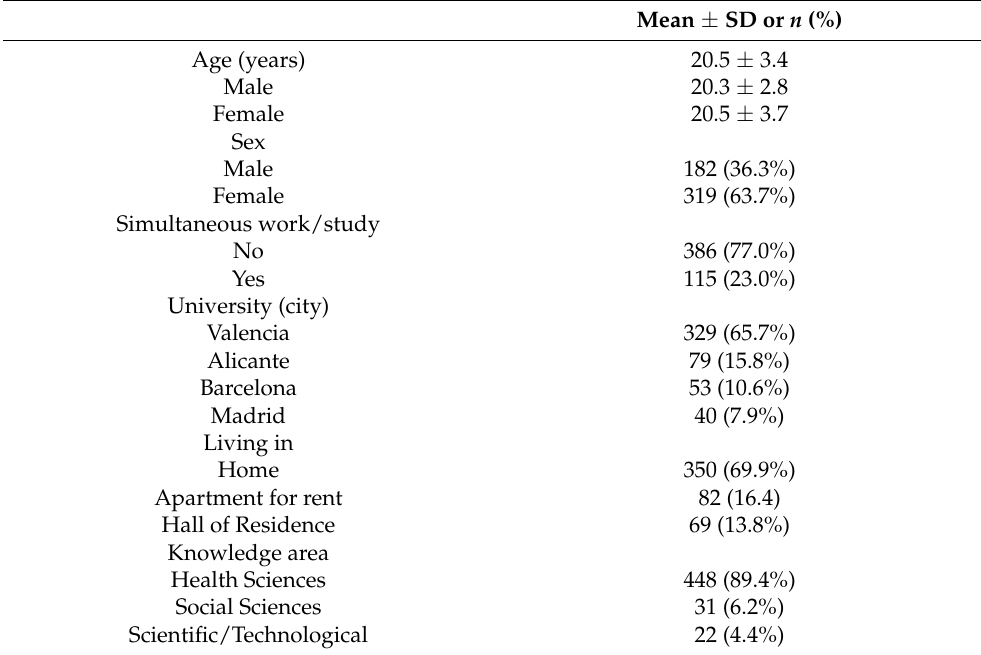
Table 2. Sociodemographic characteristics of the